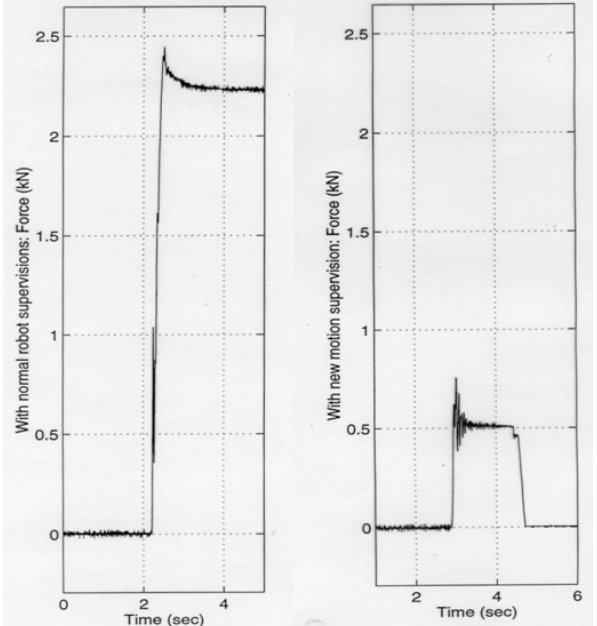
Figure 5: Collision force between robot tool and work object with model-based collision supervision to the right and collision supervision based on control errors without the use of dynamic models to the left.